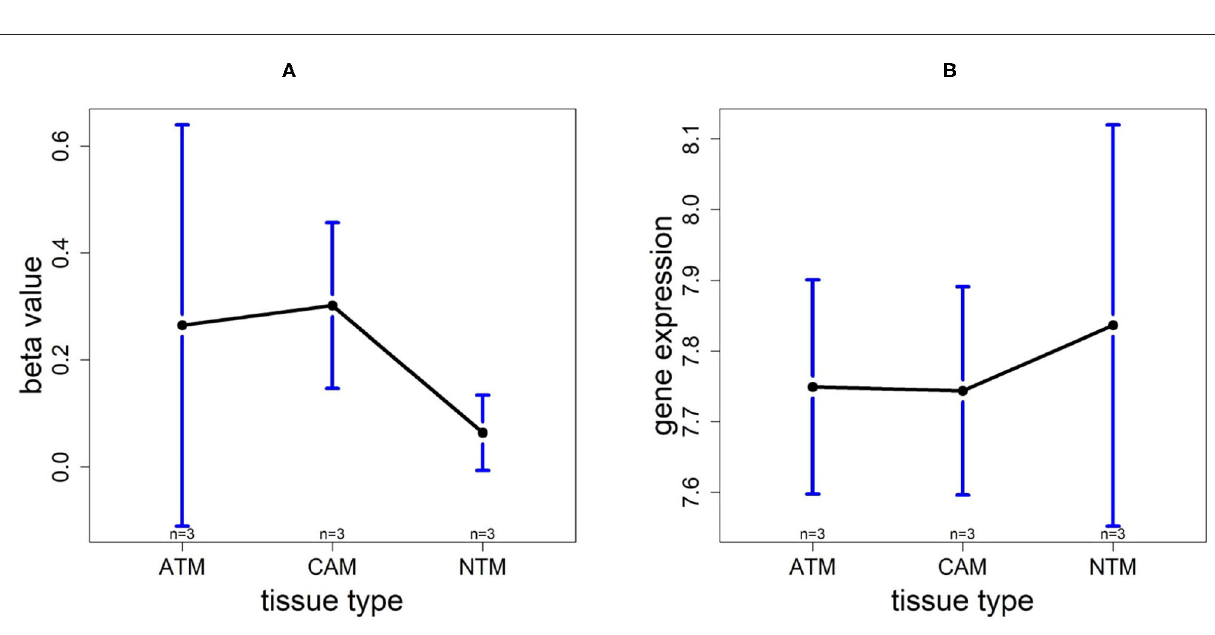
To identify prognostic markers, we used Cox regression models defined by the hazard function